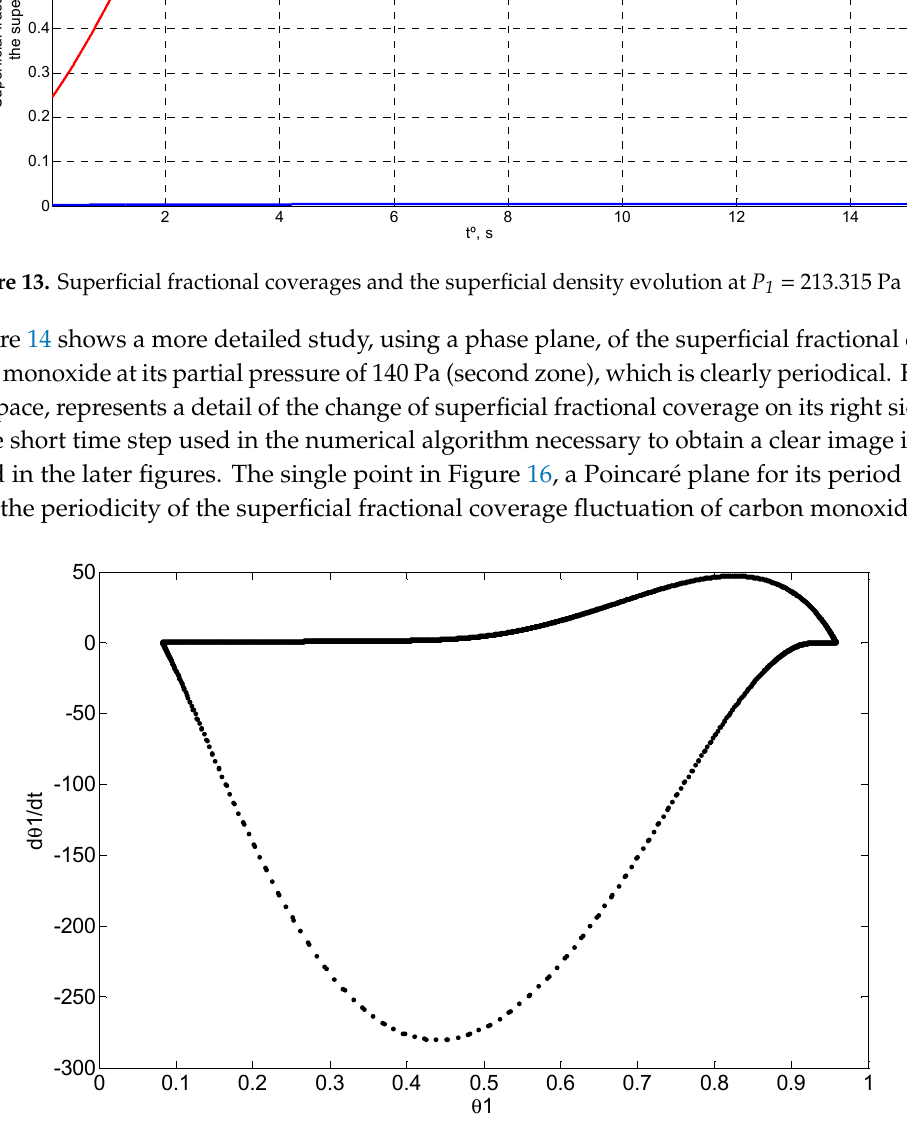
Figure 14. Phase plane of superficial fractional coverage of carbon monoxide at P 1 = 140 Pa and time step = 10 − 4 s.